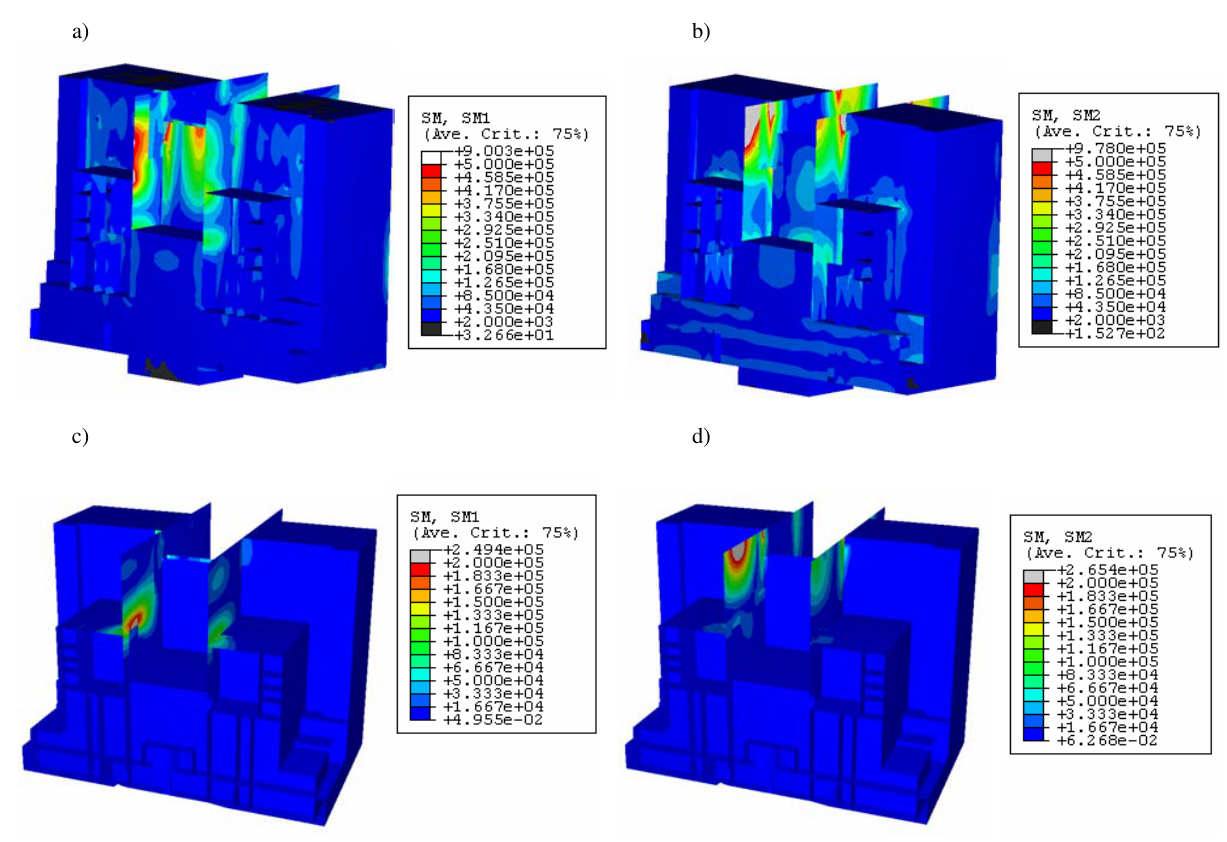
Fig. 15. Distribution of bending moments (Nm / m) in the East-West cross-section: a, c – in the “1” global axis direction; b, d – in the “2” global axis direction of reduced mass model and reduced stiffness model respectively